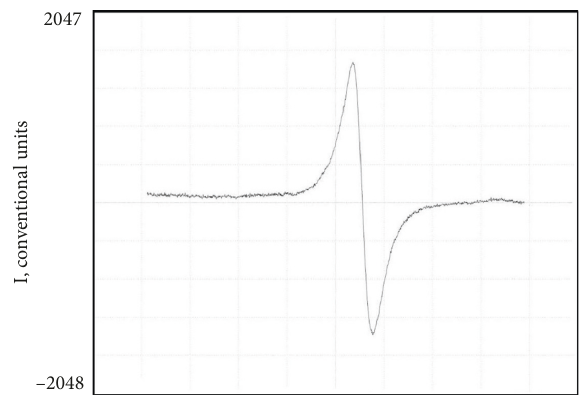
Figure 5: The ESR spectra of HAs were isolated from the study